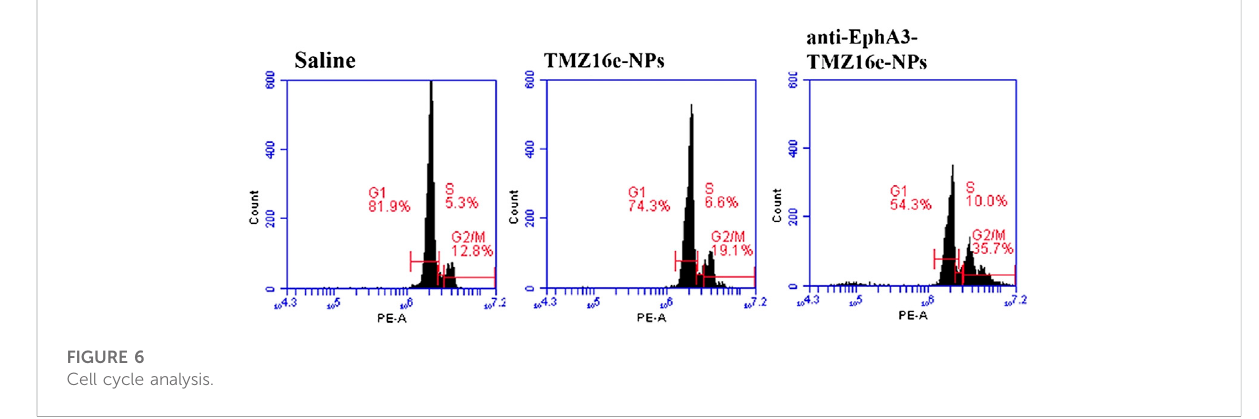
FIGURE 6 Cell cycle analysis.